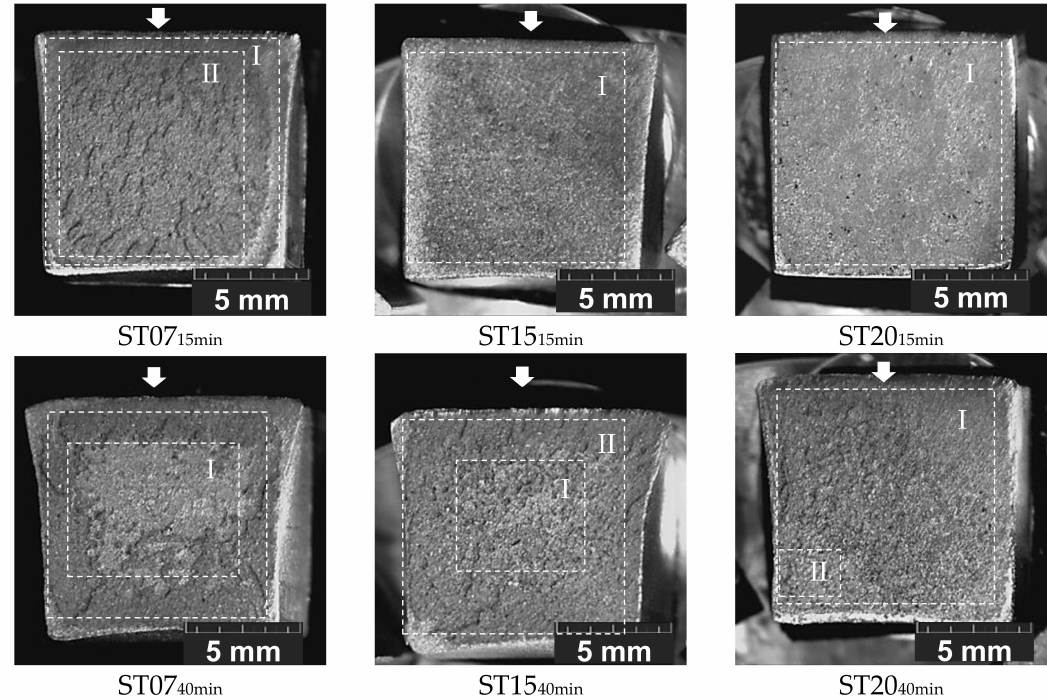
Figure 19. Fracture surfaces after impact tests.